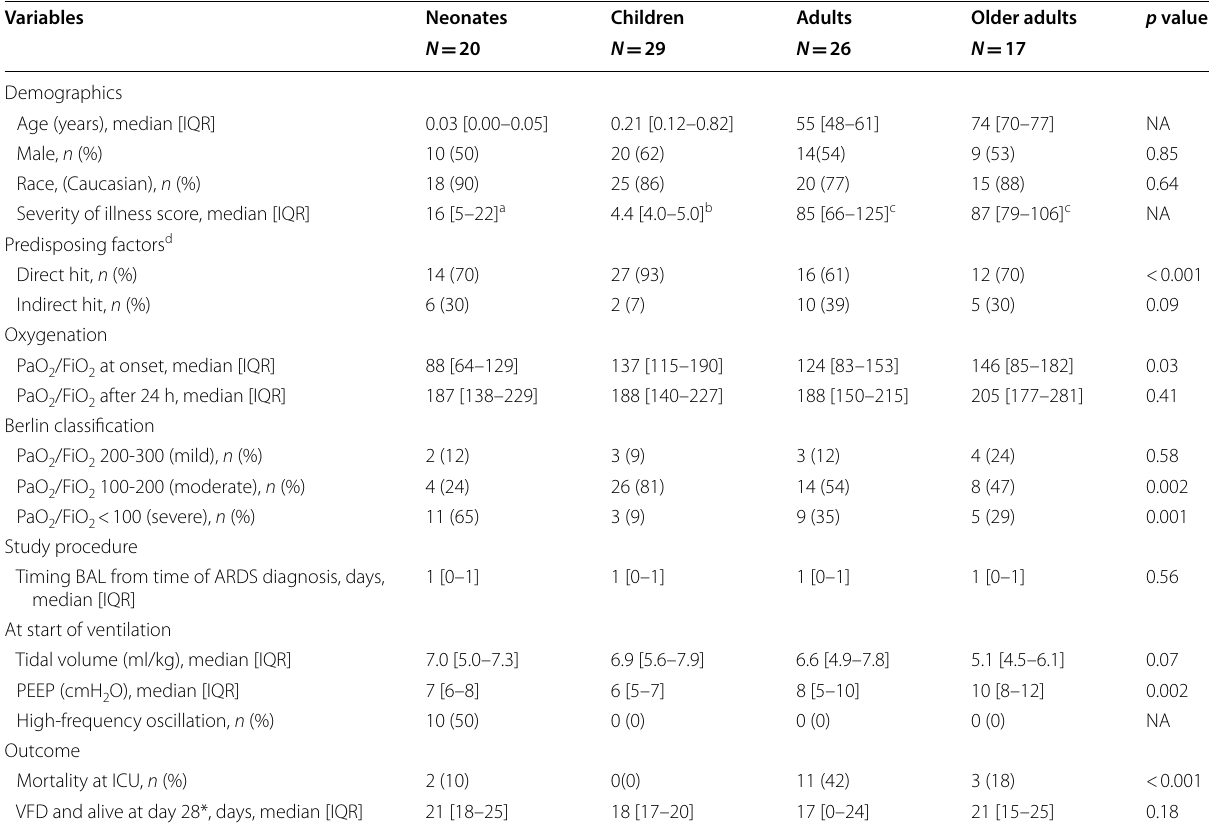
Table 1 Baseline characteristics and outcome